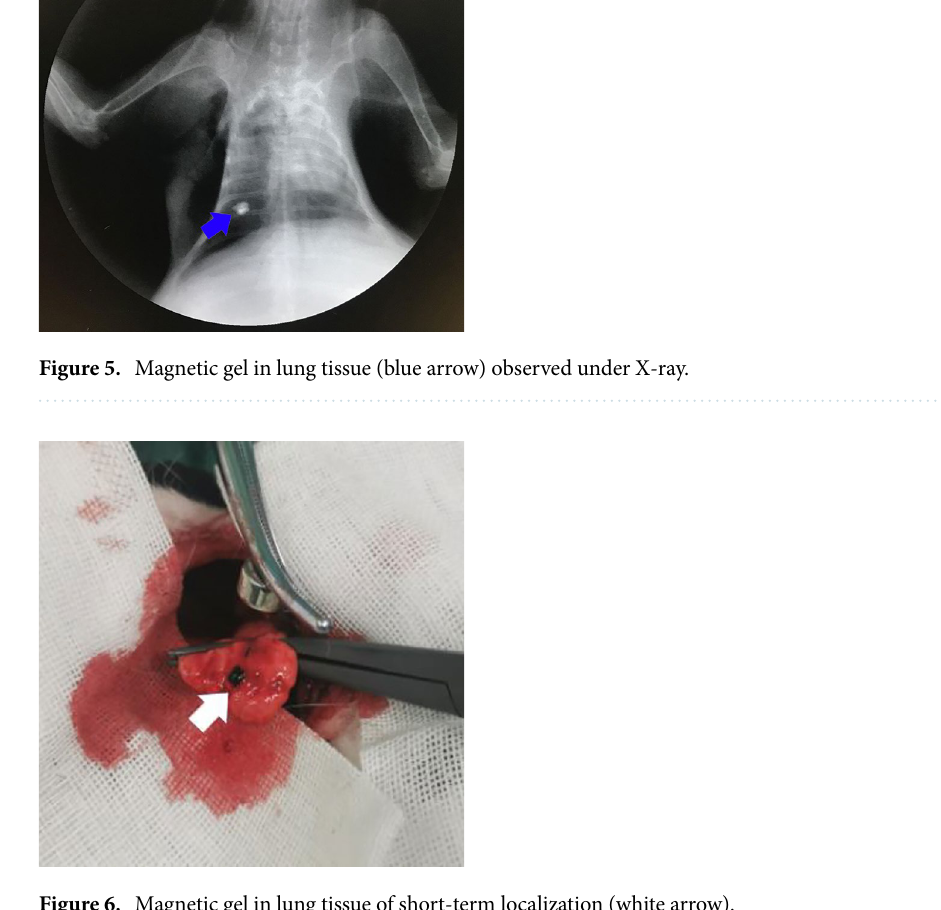
Figure 6. Magnetic gel in lung tissue of short-term localization (white arrow).